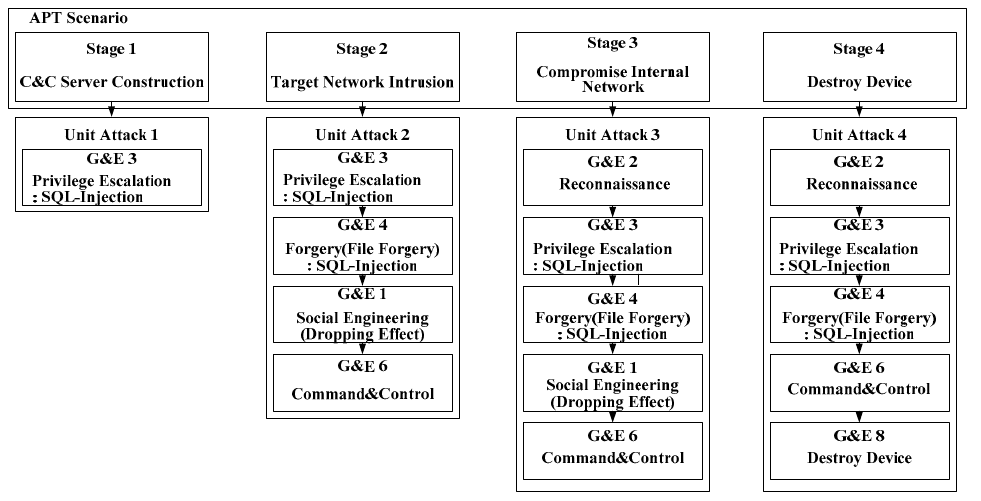
Figure 6. Advanced persistent threat (APT) scenario using the proposed hierarchical multi-stage attack scenario modeling method.